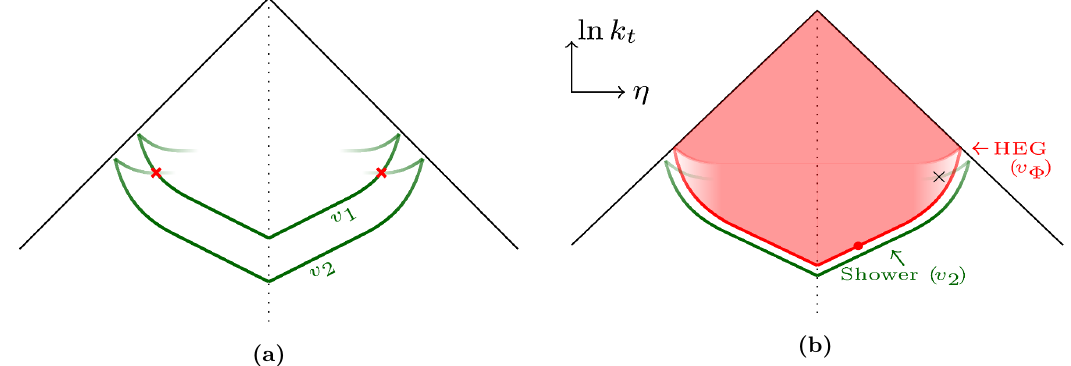
Figure 2. Schematic illustration of the issue associated with gluon asymmetrisation. (a) Contours on the Lund plane, in the PanLocal family of showers, highlighting the fact that a given physical point X in the Lund plane (highlighted with a red cross) can come from two different values of v . The shading of the green curves represents the variation in radiation intensity along the contour. (b) Density plot, at each point in the Lund plane, representing schematically the fraction of the emission intensity at that point that has been excluded once the HEG has reached a given v value ( v ) without emitting, and an illustration that as the shower continues there may still be phase- Φ space points (such as that marked with a cross) where the Sudakov has only been partially accounted for. The implications are discussed in the